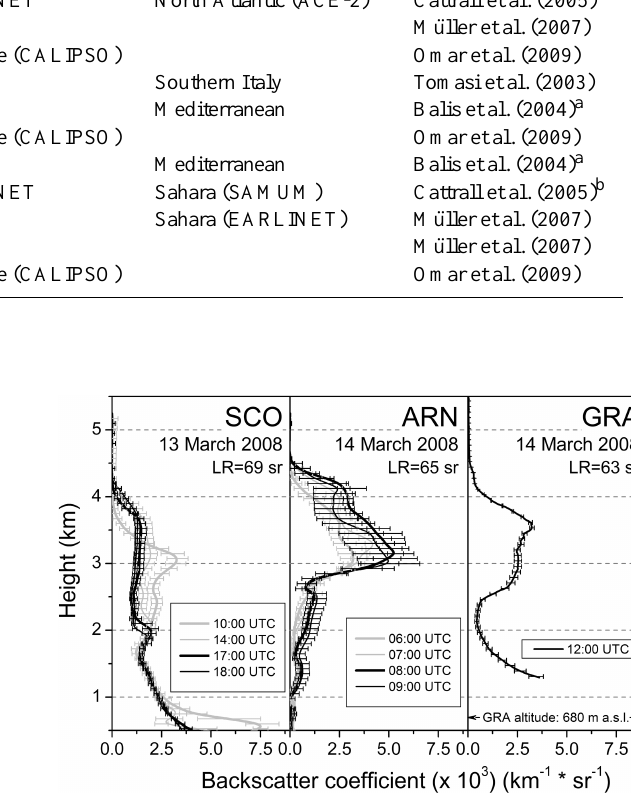
Fig. 8. Height-resolved backscatter coefficients (1-h averaged pro- files) at discrete times (see legend) under dusty conditions over SCO site (left), ARN (centre) and GRA (right) stations. Both lidar- retrieved LR and date of measurements are indicated in each